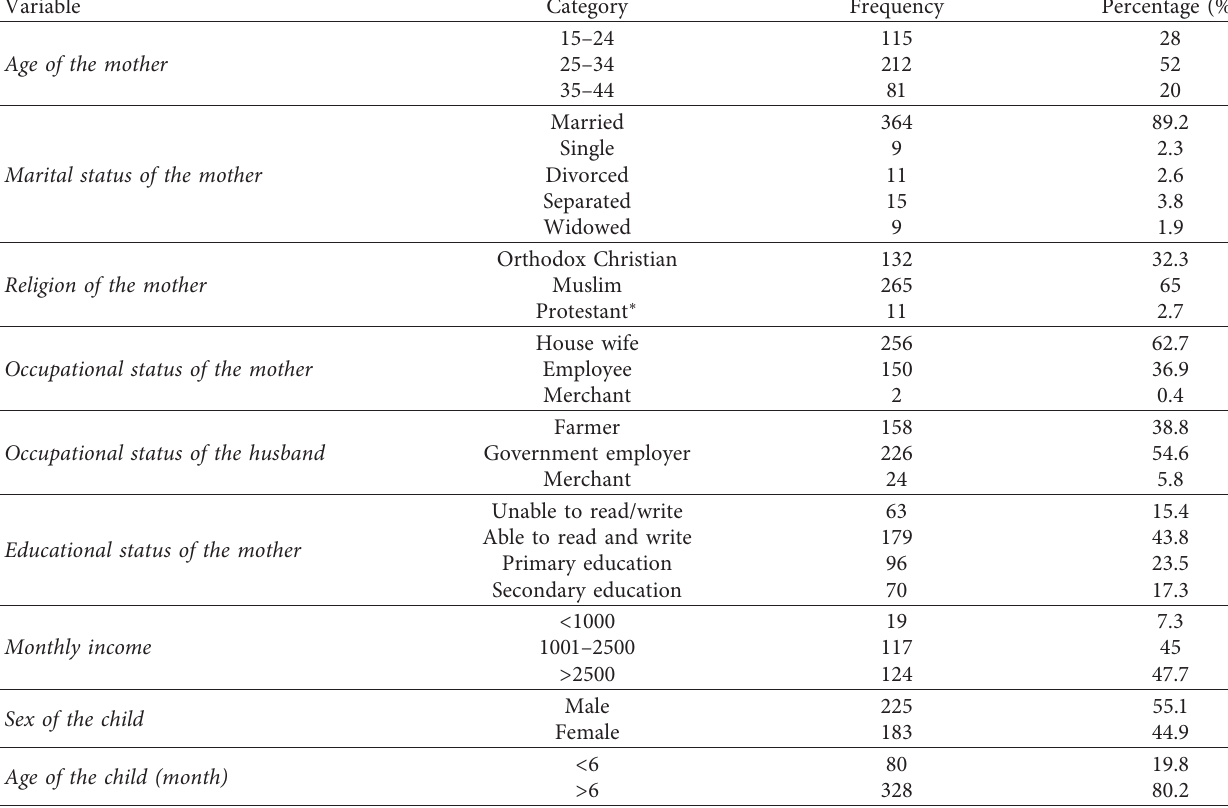
Table 1: Sociodemographic characteristics of mothers and children ( n � 408) in Ethiopia, 2019.